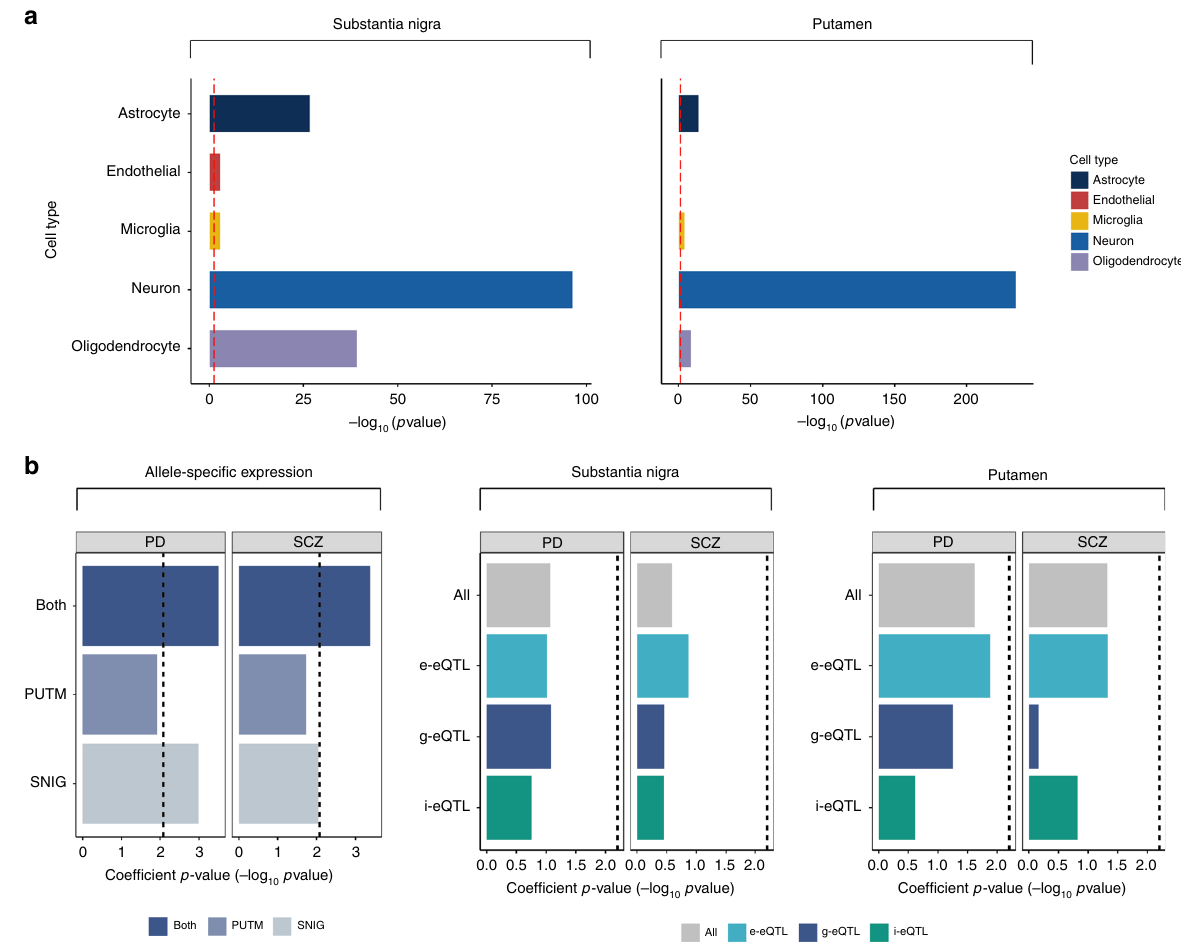
Fig. 7 Allele-speci fi c expression sites biologically and disease-relevant information. a Genic locations of ASEs were highly enriched for genes with cell- biased expression in both putamen and substantia nigra. Enrichment of genes with cell-biased expression within ASE locations was performed separately for each tissue and was determined using a Fisher ’ s Exact test and a signi fi cance cutoff of p value < 0.05 (dashed red line at − log 10 ( P ) = 1.30). b Enrichment of heritability for Parkinson ’ s Disease and schizophrenia in ASEs and eQTLs identi fi ed in substantia nigra, putamen and across both tissues. Source data are provided as a Source Data fi